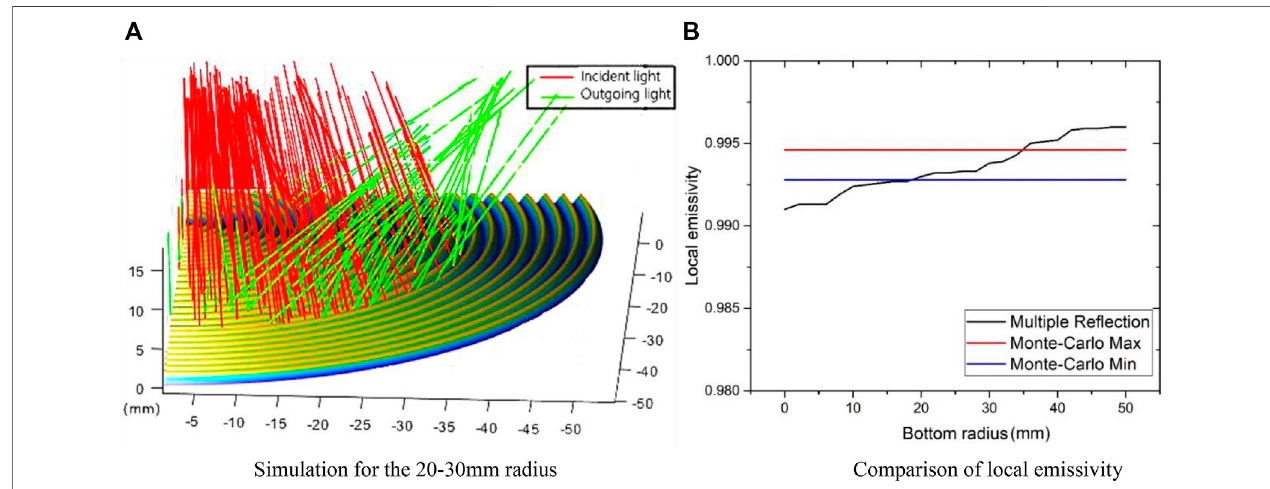
FIGURE 6 | Simulation results obtained by the multiple re fl ection method with the bottom radius. (A) Simulation for 20 – 30 mm radius and (B) comparison of local